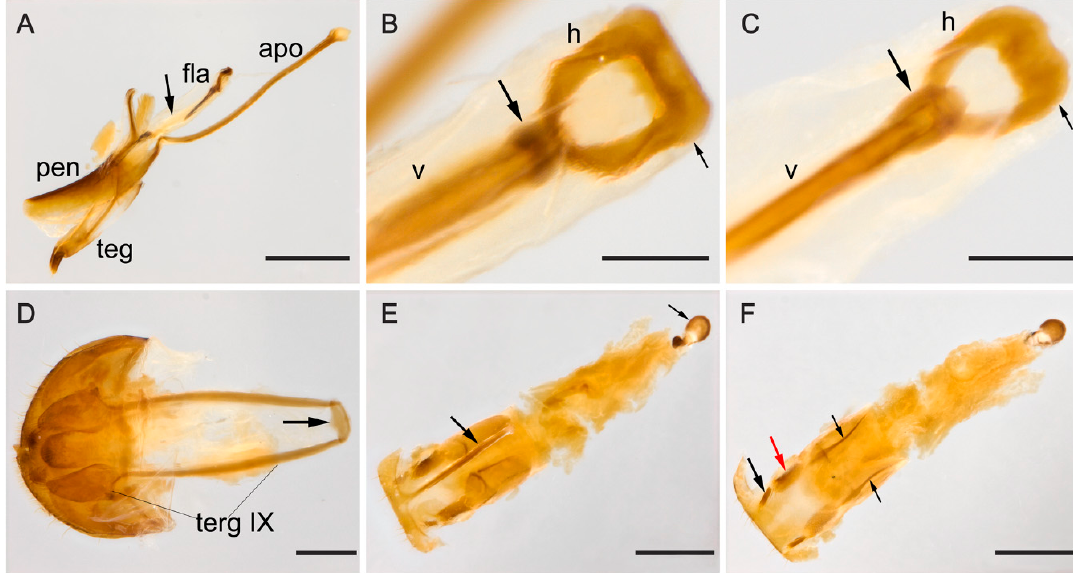
Figure 8. ( A – D ) Male abdominal terminalia of Mycotretus tigrinoides Mader, 1942 from two localities: ( A – B , D ) Sinop, MT, Brazil; ( C ) Tucuruí, PA, Brazil. ( A ) Lateral view of the aedeagus, showing apophyses (apo), flagellum (fla), penis (pen) and tegmen (teg); arrow showing a medial desclerotization in flagellum. ( B – C ) Flagellum dorsal view, showing: head (h) and anterior tip of virga (v); black arrow showing the sclerotization between virga and head, small arrow showing the outer anterior contour forming a right angle. ( D ) Abdominal segments VIII–X: laterotergite IX (terg IX), arrow showing the sclerite at the anteroventral edge of segment IX. ( E – F ) Female abdominal terminalia of a specimen from Brasília, DF, Brazil: ( E ) dorsal view, big arrow showing the median strut of sternite VIII, small arrow showing the spermatheca; ( F ) ventral view, small black and red arrows showing a gonostylus and a gonocoxite, respectively; small arrows showing baculi of paraprocts. Scale bars: A , E – F = 0.5 mm; B – C = 0.1 mm; D = 0.2 mm. Diagnosis. Pronotum with sparsely, black, free, subcircular elongated spots, asymmetrically